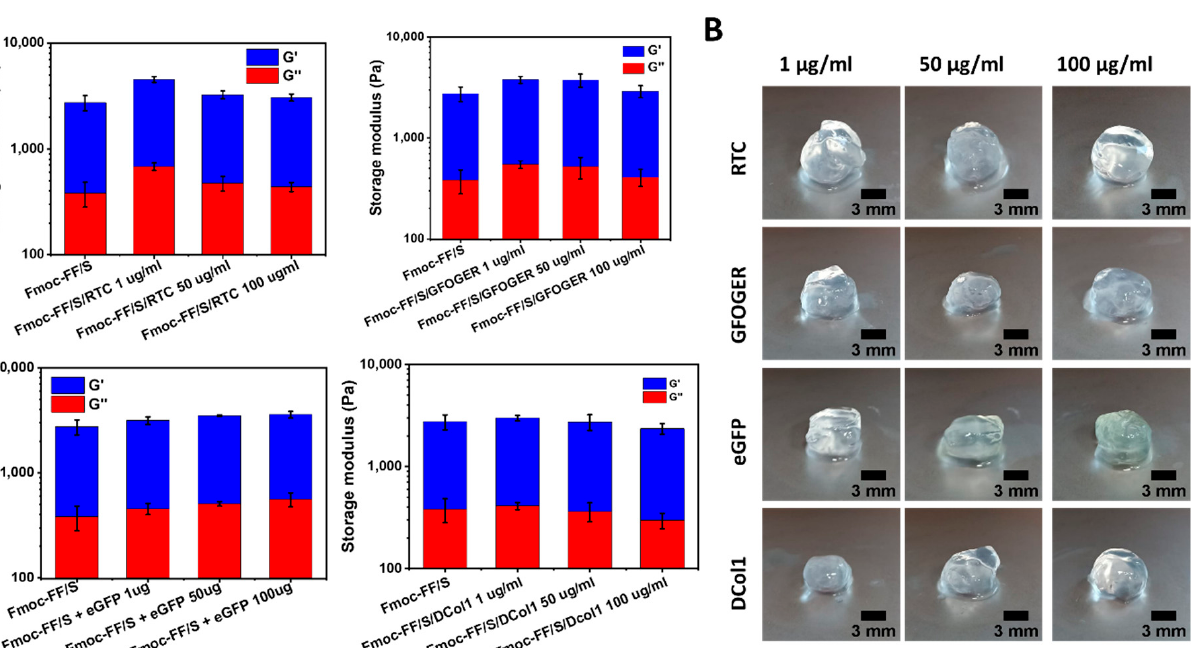
Figure 5. Analysis of the mechanical properties of the hydrogels studied. ( A ) Storage and loss moduli (0.02% strain, 1 Hz) of Fmoc-FF/S hydrogels with and without collagen at different concentrations (1, 50, 100 µg/mL). ( B ) Photographs of spheroids of Fmoc-FF/S with different collagen construct at different concentrations.